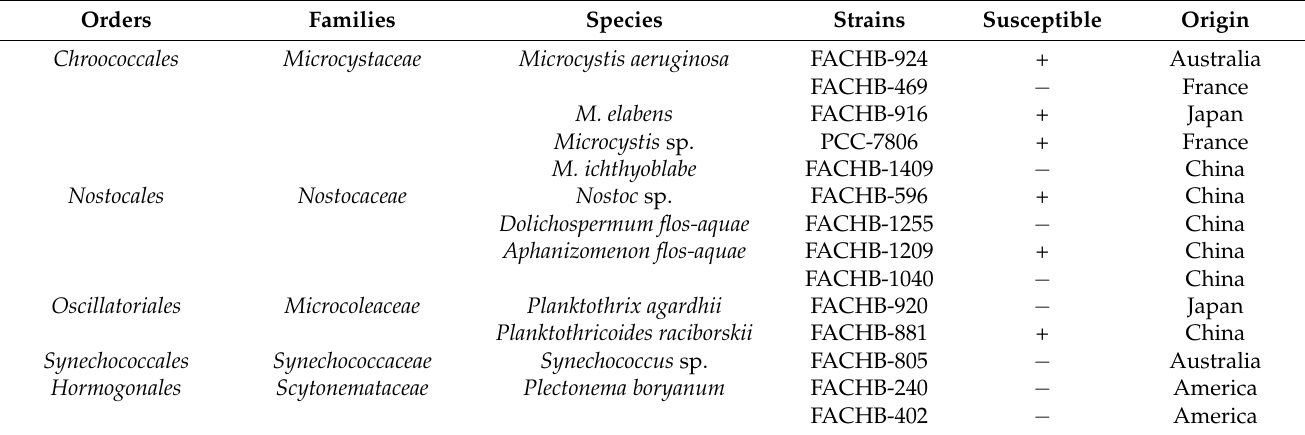
Table 1. Results of host range test of Mae-Yong924-1 against 14 cyanobacterial